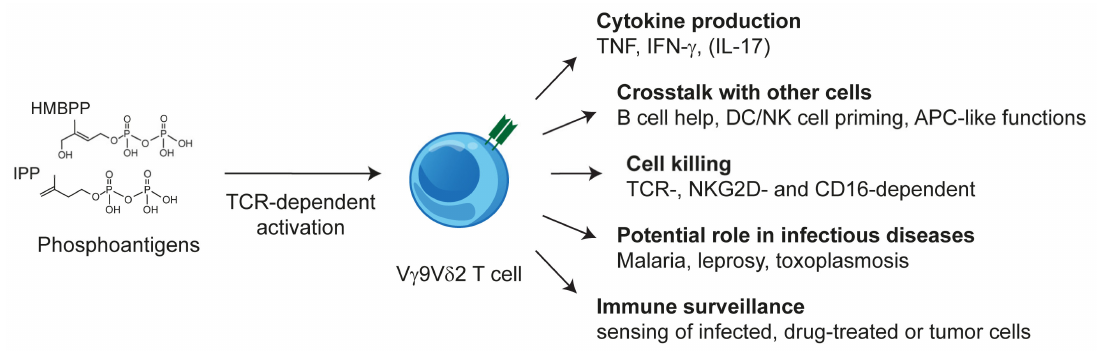
Figure 1. The multifunctionality of V γ 9V δ 2 T